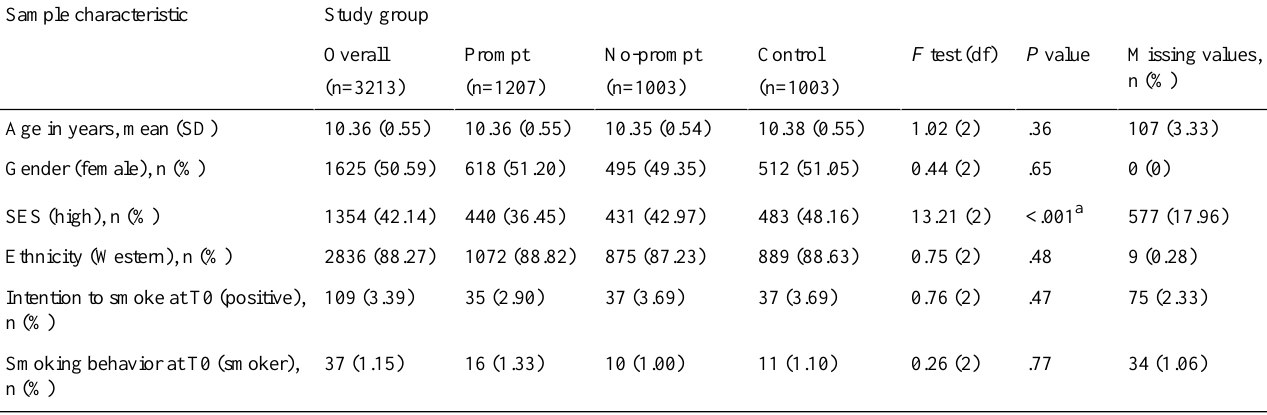
Table 1. Sample characteristics of children in each study group at T0.